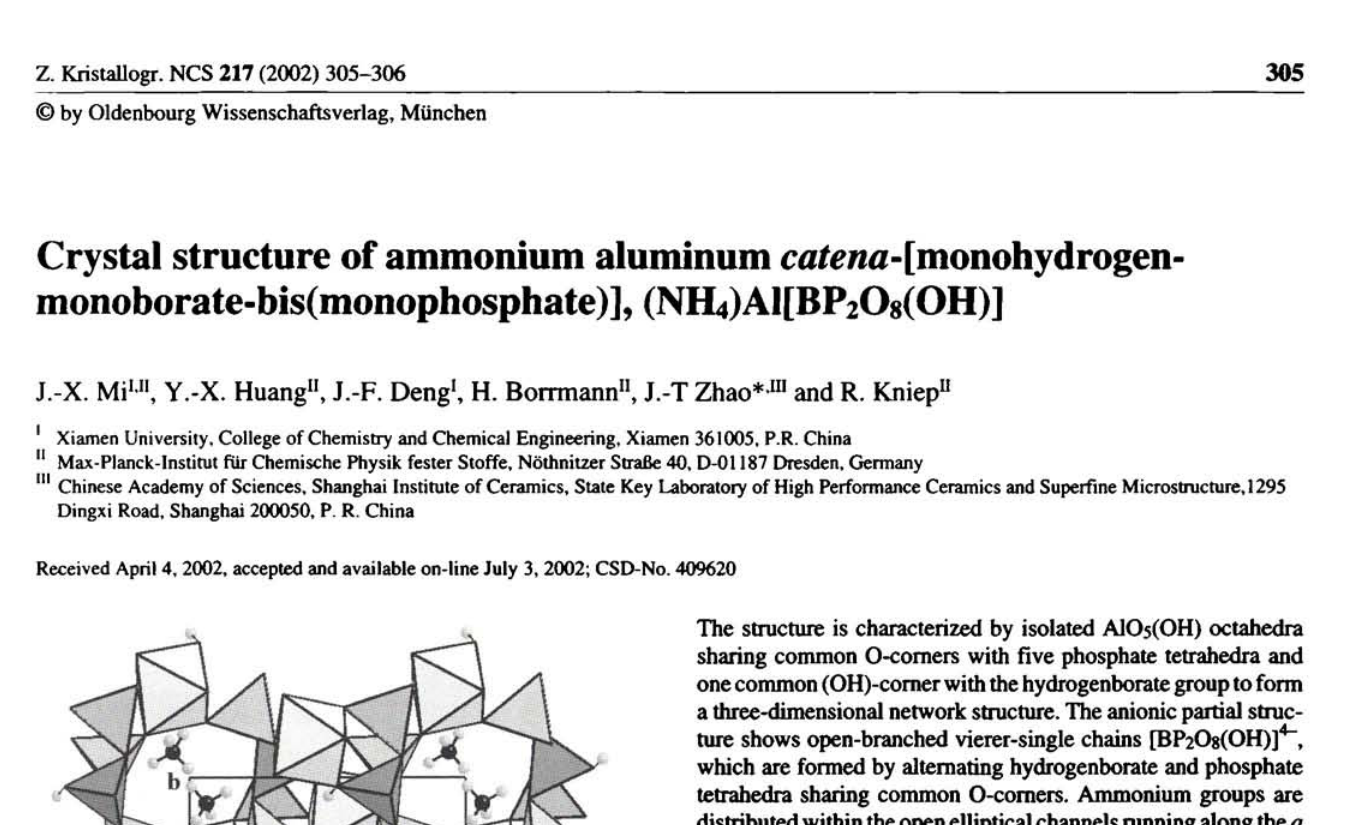
Table 1. Data collection and handling. Crystal: